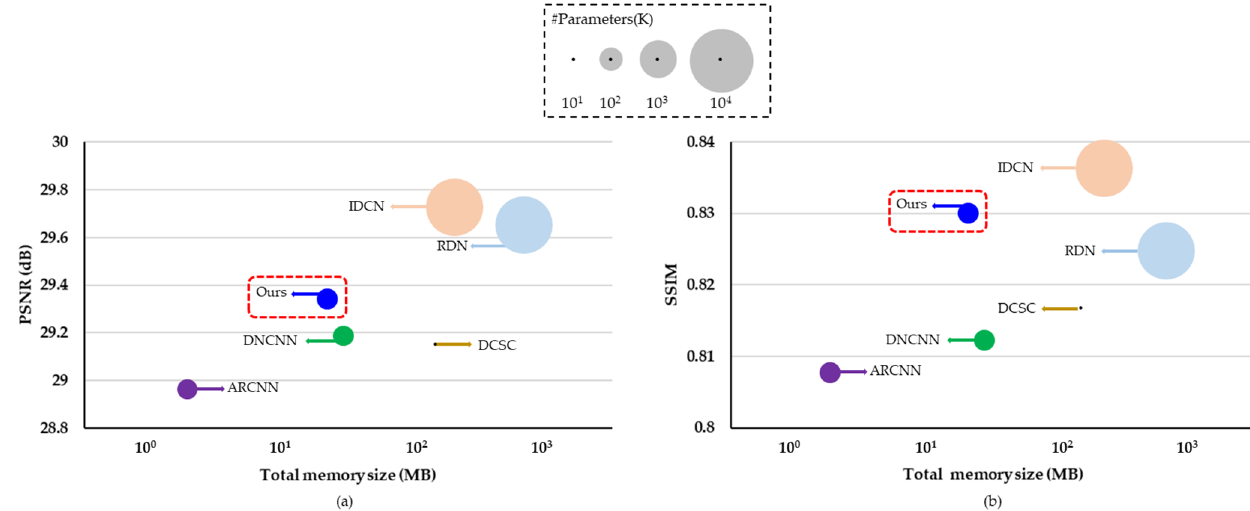
Figure 8. Comparisons of the network performance and complexity between the proposed DCRN and existing methods for the LIVE1 dataset. The circle size represents the number of parameters. ( a ) The x and y-axis denote the total memory size and PSNR, respectively. ( b ) The x and y-axis denote the total memory size and SSIM, respectively. Table 6. PSNR (dB) comparisons on the test datasets. The best results of dataset are shown in bold.